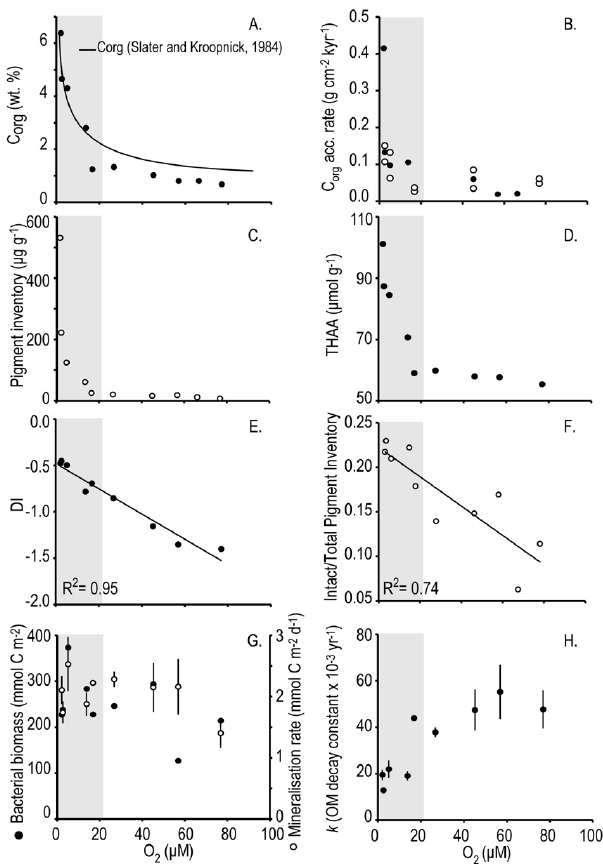
Fig. 3. Organic matter quantity, organic carbon accumulation and biochemical quality indices versus bottom-water oxygen con- tent. (A) Organic carbon with a trend line of Slater and Kroop- nick (1984); (B) organic carbon accumulation rates. The solid cir- cles indicate the values based on average sedimentation rates where as the open circles indicate the maximum and minimum accumu- lation rates. (C) Total pigment inventory; (D) total hydrolysable amino acid content (THAA); (E) DI, the amino acid degradation index; (F) intact/total pigment inventory; (G) bacterial biomass (closed symbol) and mineralisation rate (open symbol); (H) OM decay constant versus BWO content along the studies transect. The area shaded in grey represents the zone where BWO content is < 22µM and invertebrate fauna are accordingly affected by the low O 2 concentrations (Levin, 2003). The error bars in plots G and H represent the standard deviation of two replicate incubations. No error bars are available for bacterial biomass as the sediment was pooled for bacterial PLFA analyses (G)